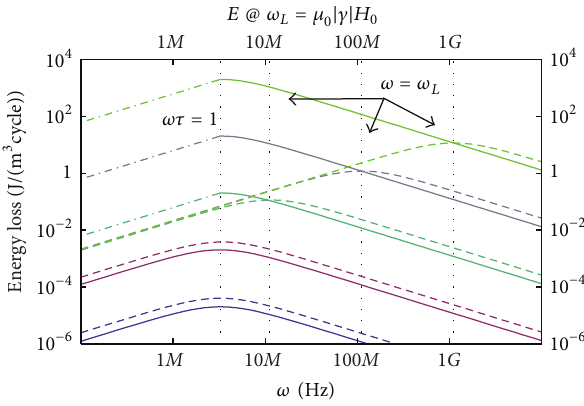
Figure 6: (colour online) Energy loss as a function of frequency 𝜔 , parameterized by field strength 𝐻 0 = {10 4 ,10 3 ,10 2 , 10 1 , 10 0 } A/m from top to bottom. Solid lines correspond to linear polarization, dashed lines to circular. Vertical lines are at resonance 𝜔𝜏 and at the Larmor frequency belonging to 𝐻 0 = {10 4 , 10 3 , 10 2 } A/m from right to left. The calculation was done at magnetite nanoparticle of radius 5 nm and 𝜏 = 3 × 10 −7 s.